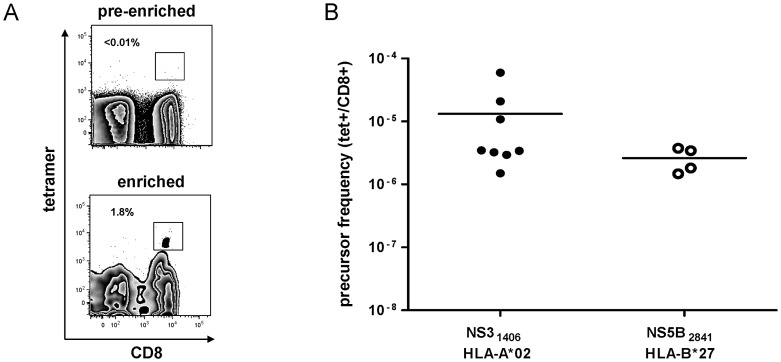
Precursor frequency of HCV-specific CD8+ T cells.(A) Representative flow cytometry plots of PBMCs from a healthy donor displaying staining with the NS5B2841/HLA-B*27 tetramer before and after magnetic-bead enrichment. Percentage of tetramer+ CD8+ T cells is indicated. (B) Precursor frequencies of CD8+ T cells specific for NS31406 (HLA-A*02 tetramer, filled circles) and NS5B2841 (HLA-B*27 tetramer, open circles) detected in healthy donors after tetramer staining, magnetic-bead enrichment and multiparametric flow cytometric analysis. The enriched tetramer+ CD8+ T-cell populations were stained for CD45RA, CD27, CCR7 and CD11a. The number of phenotypically naïve (CD45RAhi, CD27hi, CCR7hi, CD11alow) tetramer+ CD8+ T cells relative to the number of total CD8+ T cells is indicated. Horizontal bars represent mean values.